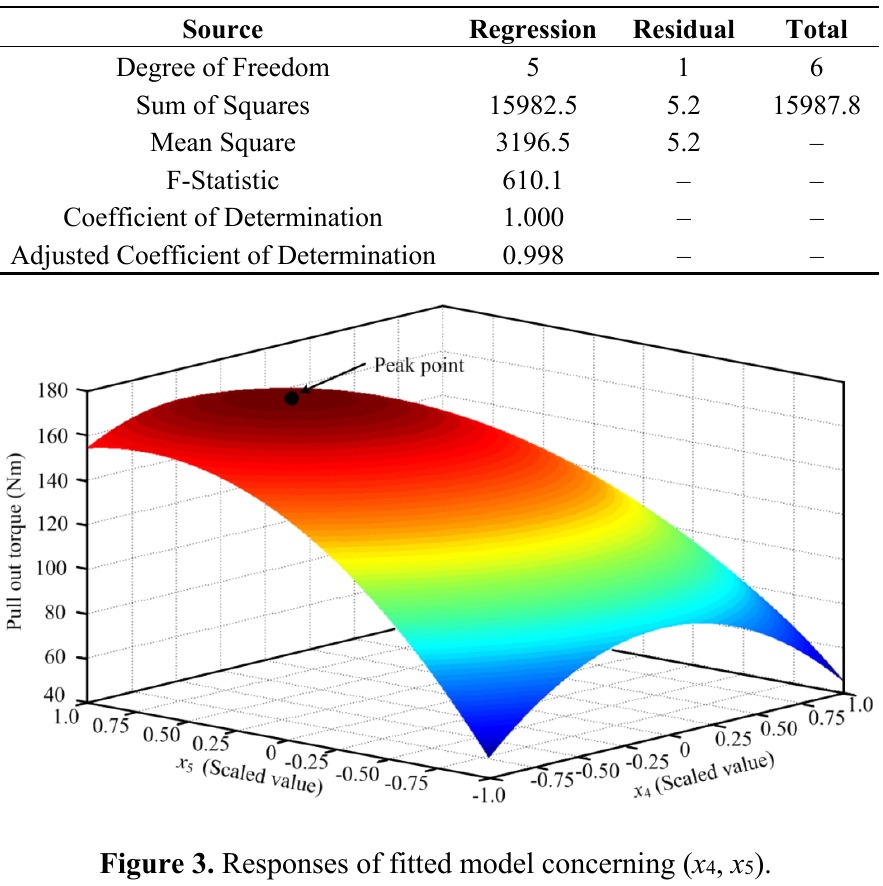
Table 5. Analysis of variance for optimizing stator slot.